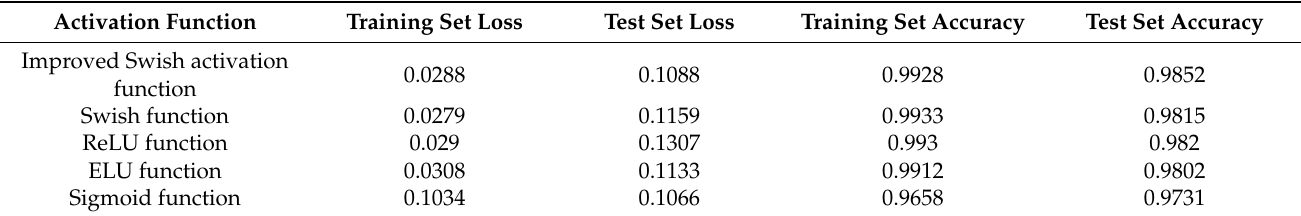
Table 2. Comparison of the best loss and accuracy value for each activation function.